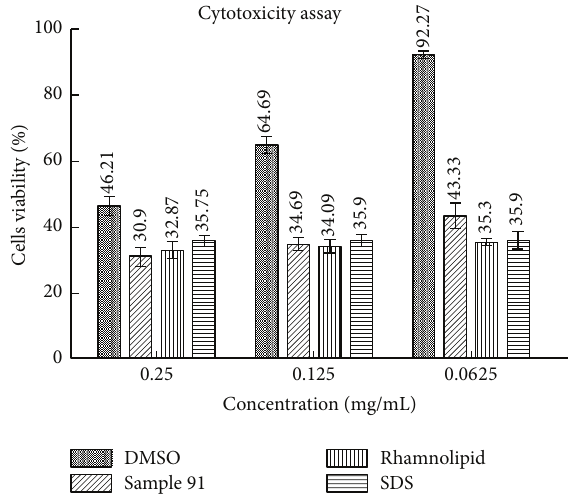
Figure 7: Cytotoxicity evaluation of biosurfactant at different concentration of